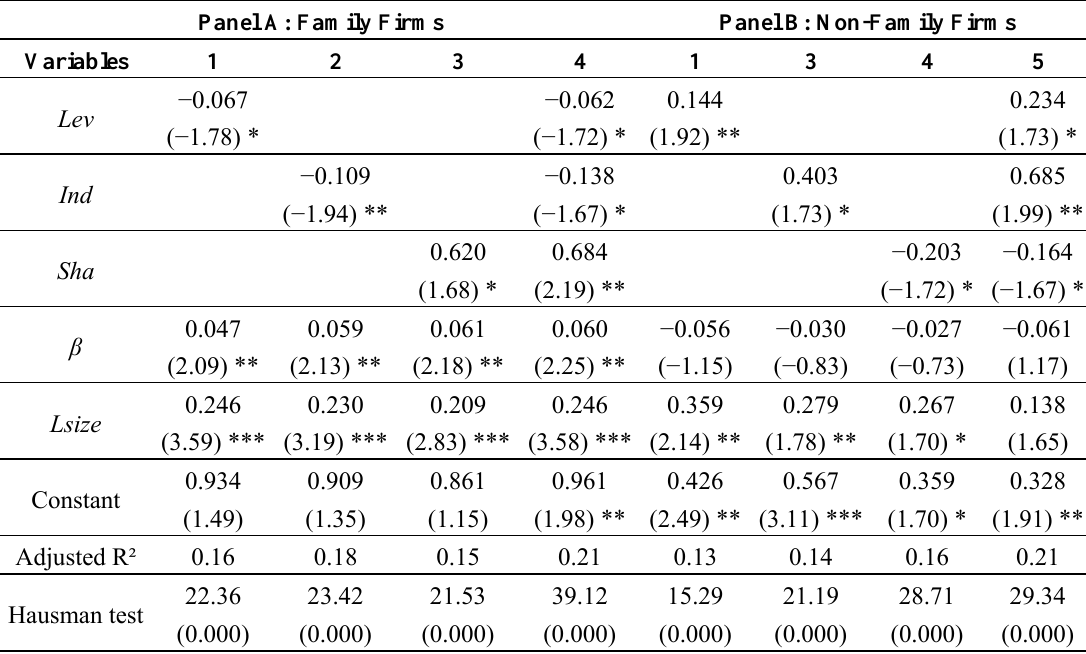
Table 5. Results of estimations based on family and non-family sample (family holds more than 51 percent